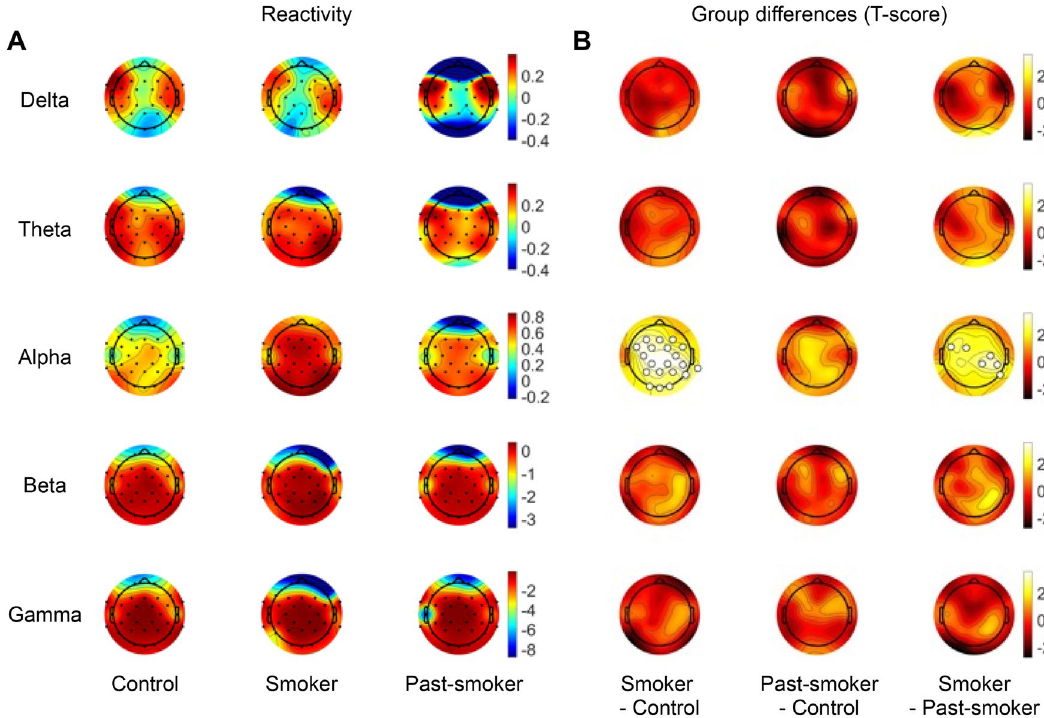
Figure 2. EEG reactivity between the eyes-closed and the eyes-open conditions. ( A ) Each row illustrates average EEG reactivity measures calculated in each group, for each frequency band. ( B ) Statistical group differences in EEG reactivity were observed in alpha band. Particularly, smokers showed larger alpha reactivity compared with past-smokers or non-smoking controls. The channels that showed a significant group difference are marked with larger unfilled markers ( P FDR <